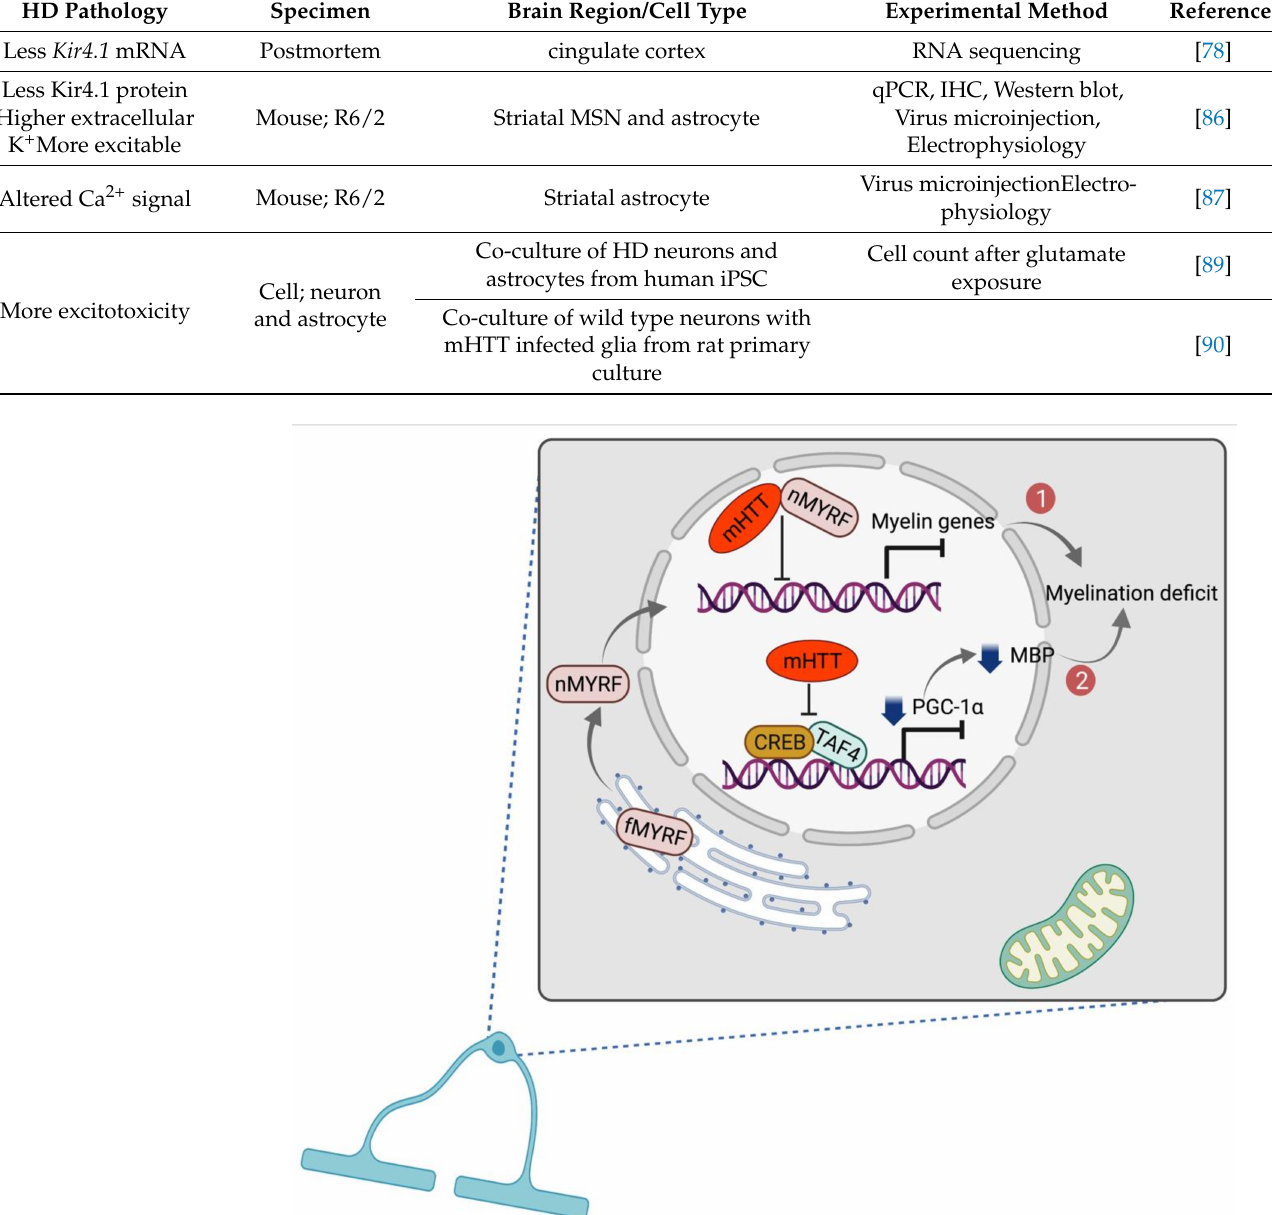
Figure 2. Oligodendrocyte dysfunction in HD. In the first pathway, full-length MYRF is self-cleaved to nMYRF which detaches from ER and is translocated to the nucleus to regulate the expression of myelin related genes. In HD, N-terminal mHTT binds nMYRF causing abnormal binding of nMYRF and deficit myelin genes expression. Second pathway shows inhibition of PGC-1 α expression by interference of mHTT in co-binding of CREB and TAF4, leading to reduced activity in the cholesterol biosynthesis pathway and myelination deficit. Created with